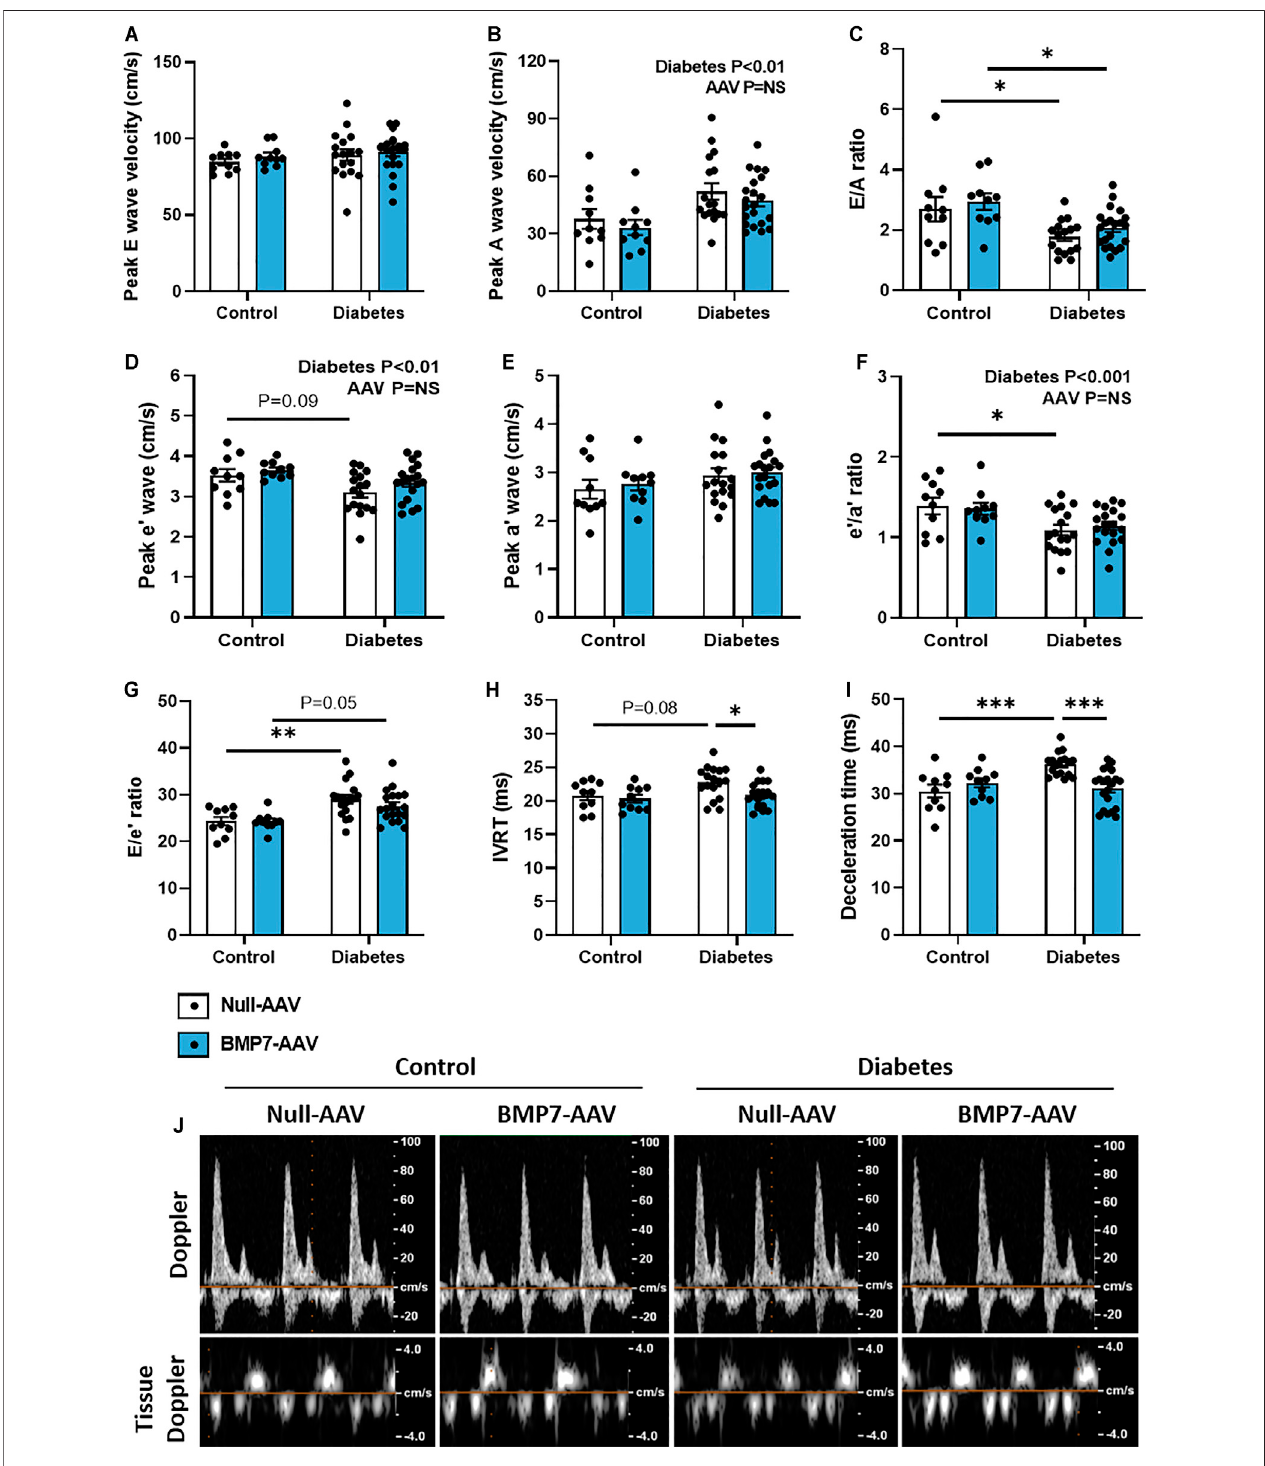
FIGURE2| TheeffectofrAAV6-BMP7genetherapyondiabetes-inducedLVdiastolicdysfunction.Dopplerechocardiographywasusedtoderive (A) peakEwave velocity, (B) peak A wave velocity, (C) E/A ratio, (D) peak e ’ wave velocity, (E) peak a ’ wave velocity, (F) e ’ /a ’ ratio, (G) E/e ’ ratio, (H) isovolumic relaxation time (IVRT), (I) deceleration time, as depicted in the (J) representative images. Data are presented as mean ± SEM. n (cid:1) 10 – 21 per group (see individual data points). * p < 0.05, ** p < 0.01, *** p < 0.001. Two-way ANOVA followed by Tukey ’ s post hoc test. AAV, adeno-associated virus; BMP7, bone morphogenetic protein 7.